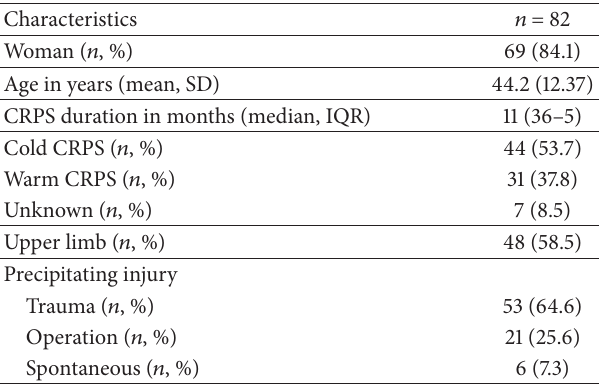
Table 1: Patients’